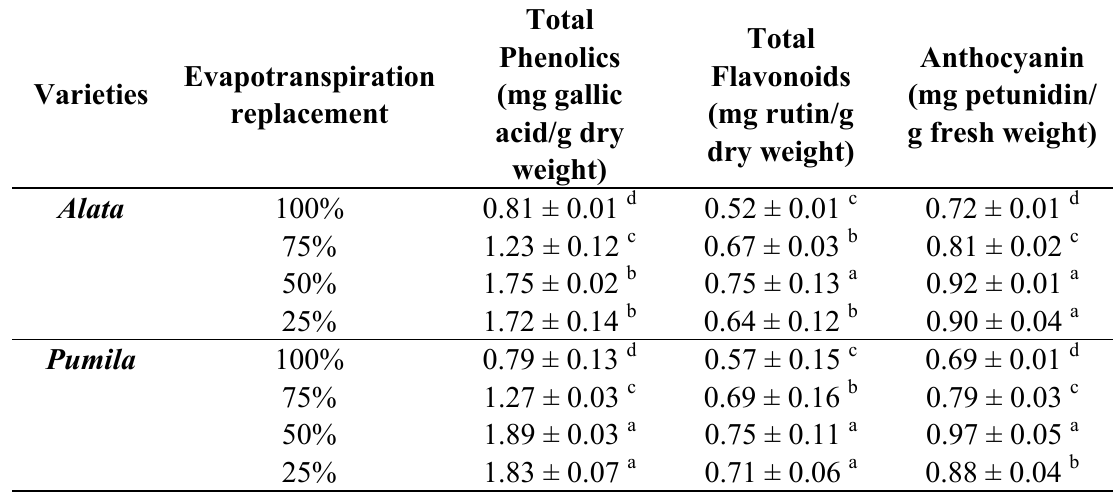
Table 1. Interaction effects between varieties and evapotranspiration replacement on leaf total phenolics, flavonoids and anthocyanin